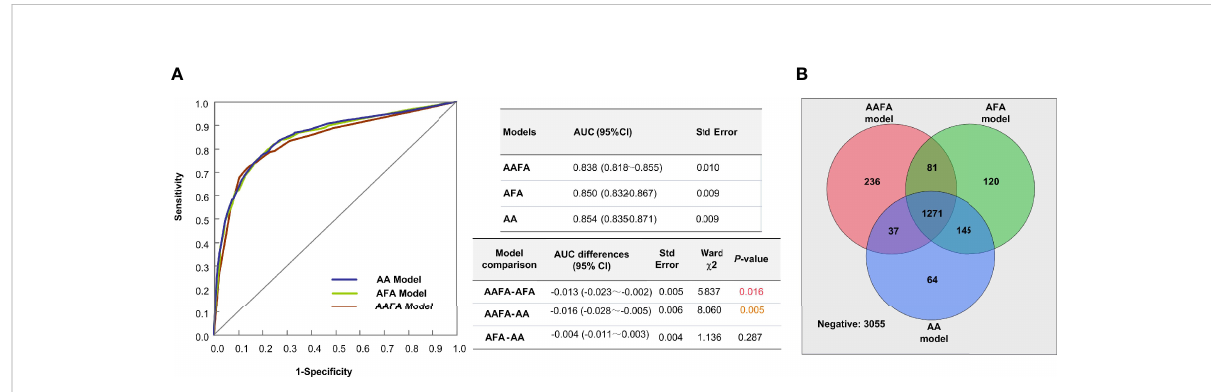
FIGURE 2 The performances of the three ovarian reserve models-AAFA, AFA, and AA-using the external validation dataset. (A) AUC Comparison of the three ovarian reserve models. For model comparison, AAFA-AFA means the AUC of AAFA minus the AUC of AFA, its result is indicated in the column of AUC differences. (B) The Venn diagram shows the predicted negative and positive POR estimates of the three models in this 2019 external veri fi cation